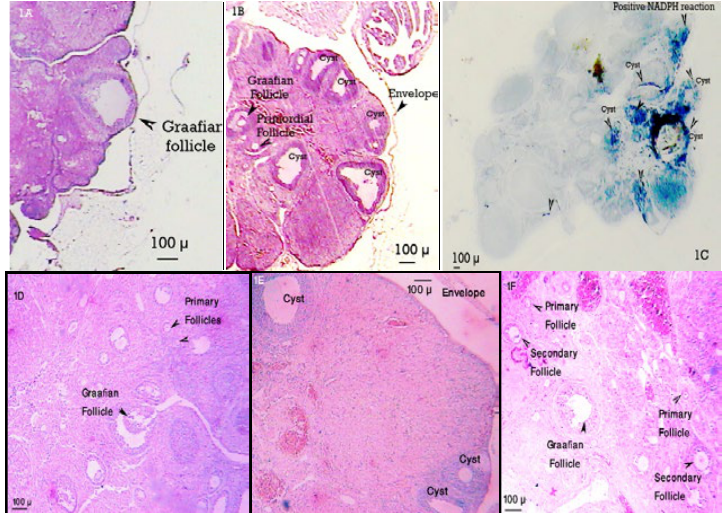
Fig. 1. Panels show the ovaries of different groups of rats: control (1A), morphine - addicted (10 - 100 mg/kg) - (1B), morphine addicted (10 - 100 mg/kg) which was given NADPH-diaphorase test (1C), saline microinjected into the VMH (1D), morphine microinjected into the VMH (1E), Ag-NPs microinjected into the VMH prior to (along with) morphine (1F). The Bars on the pictures show the µm values. The arrows and notes also signify the desired characteristics.